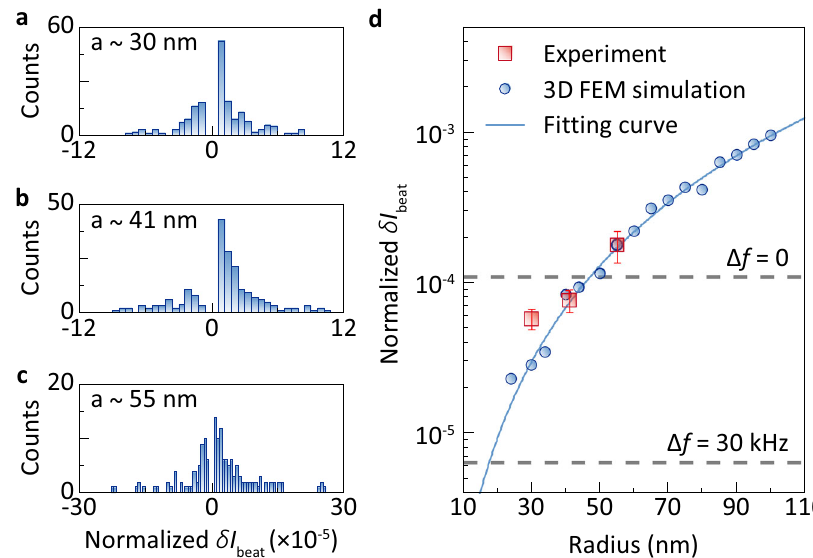
Fig. 3 Analysis of detection limit. a – c Histograms of normalized beat intensity change δ I beat for standard polystyrene nanobeads with radii of 30 nm ( a ), 41 nm ( b ), and 55 nm ( c ). d Normalized δ I beat induced by standard polystyrene nanobeads versus radius. Blue dots are the scattering ef fi ciencies of the nanoparticle obtained by 3D FEM simulation. The fi tting curve shows a 2.85 dependence. The dashed lines are the noise levels for Δ f = 0 and 30 kHz, respectively. Error bars represent the standard deviation.